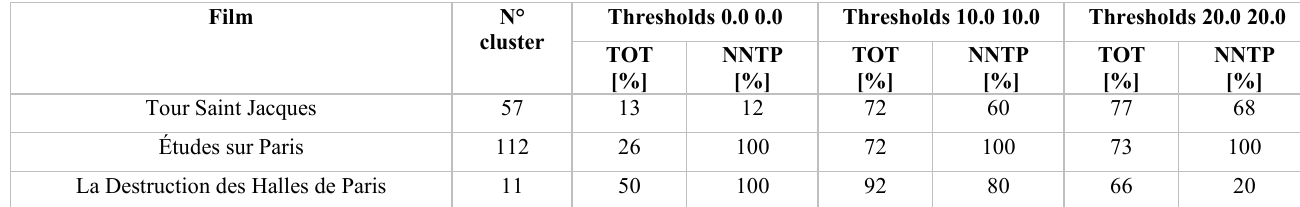
Table 1. Accuracy values expressed in percentage according to different clusters and